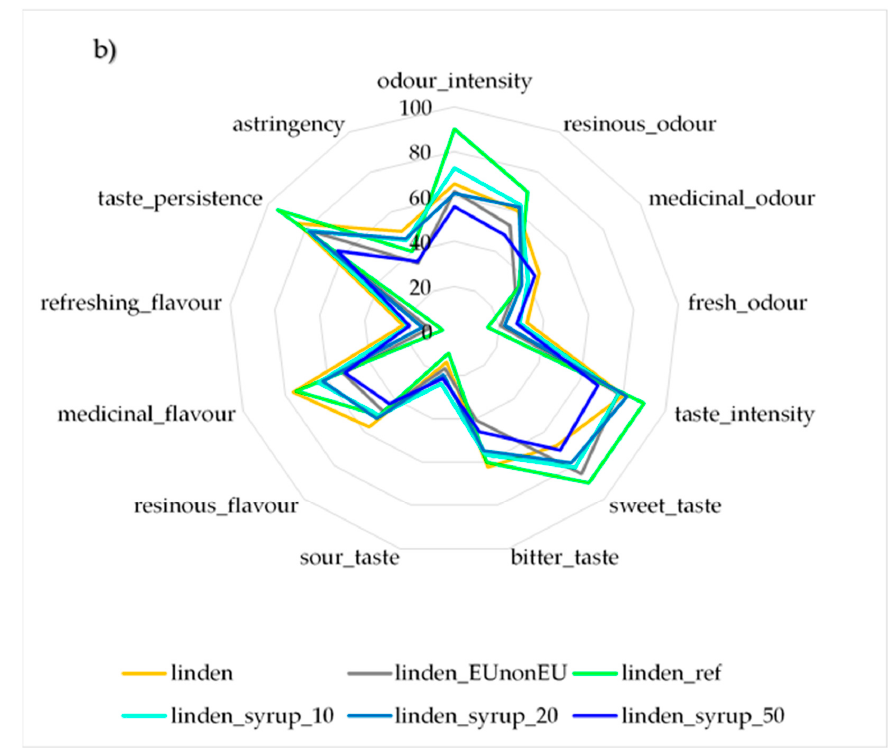
Figure 1. Results of the sensory profile analysis of ( a ) acacia and ( b ) linden honey, n = 12/parameter.